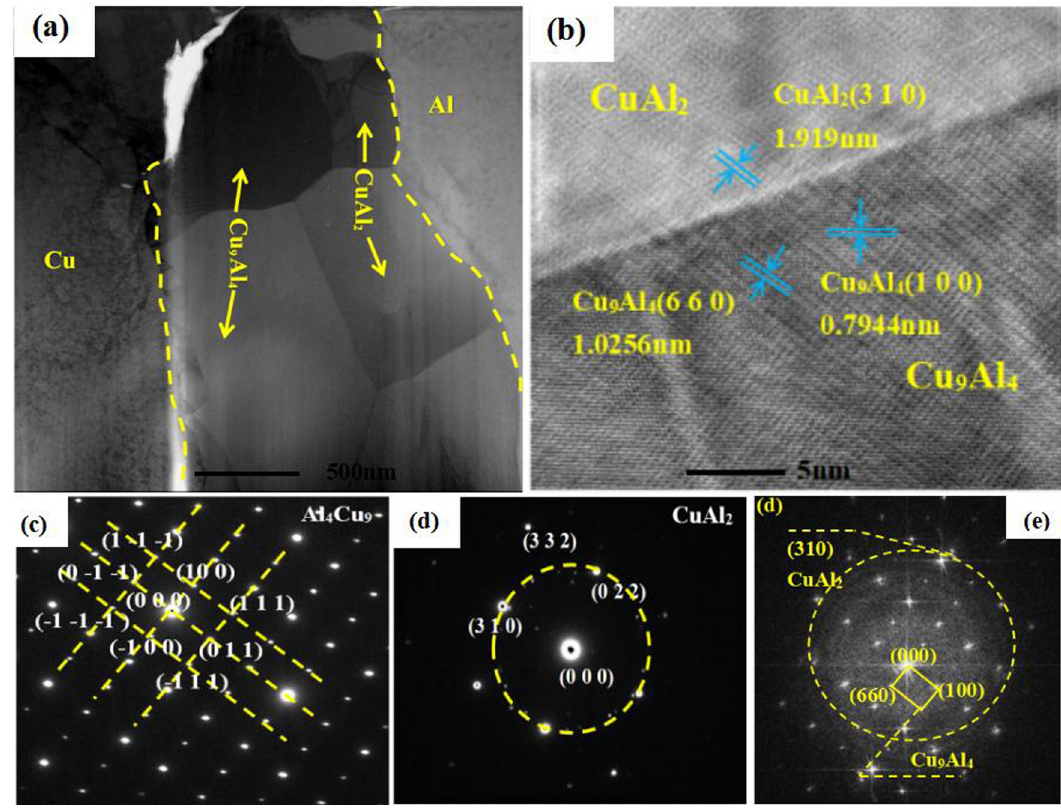
Figure 6: TEM image of interface between BAl88Si solder and Cu base metal: ( a ) low power TEM image of Cu and brazing joint interface, ( b )